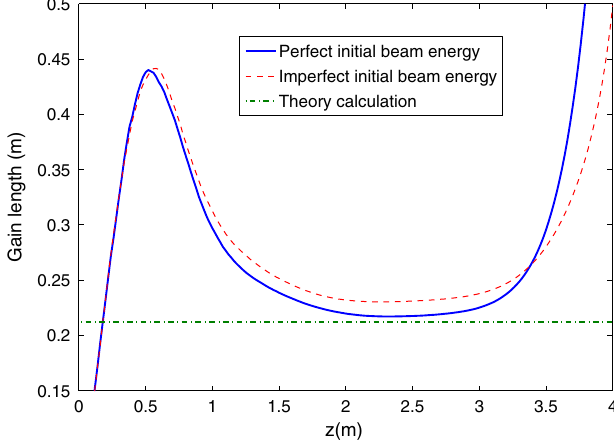
FIG. 3. (Color) Theoretical and simulation gain length curves. The theoretical gain length is a fixed number. The number is ¼ 0 : 6 , i.e., m plotted as a straight line (dot-dashed) and extended horizontally. The solid curve and the dashed curve are the simulation gain length for perfect initial beam energy and modulated initial beam energy, respectively. The simulation parameters are the same as in Fig. 2 and listed in Table I.